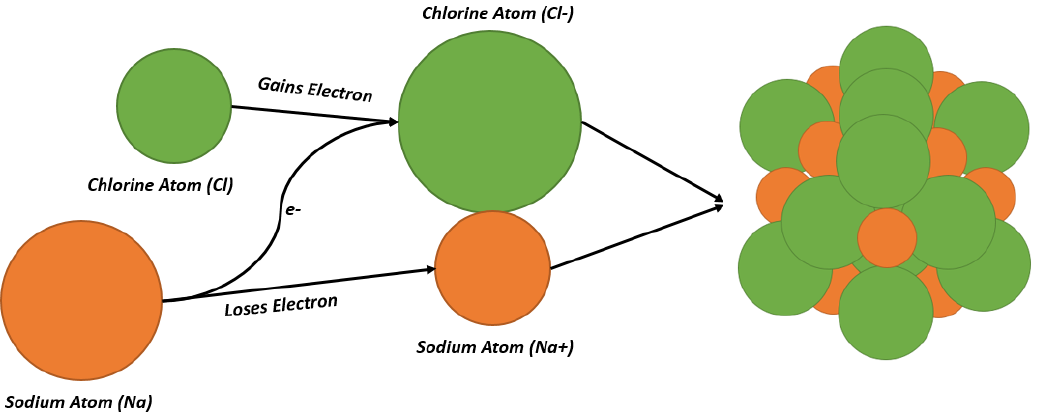
Figure 1. The formation of an ionic compound, NaCl.